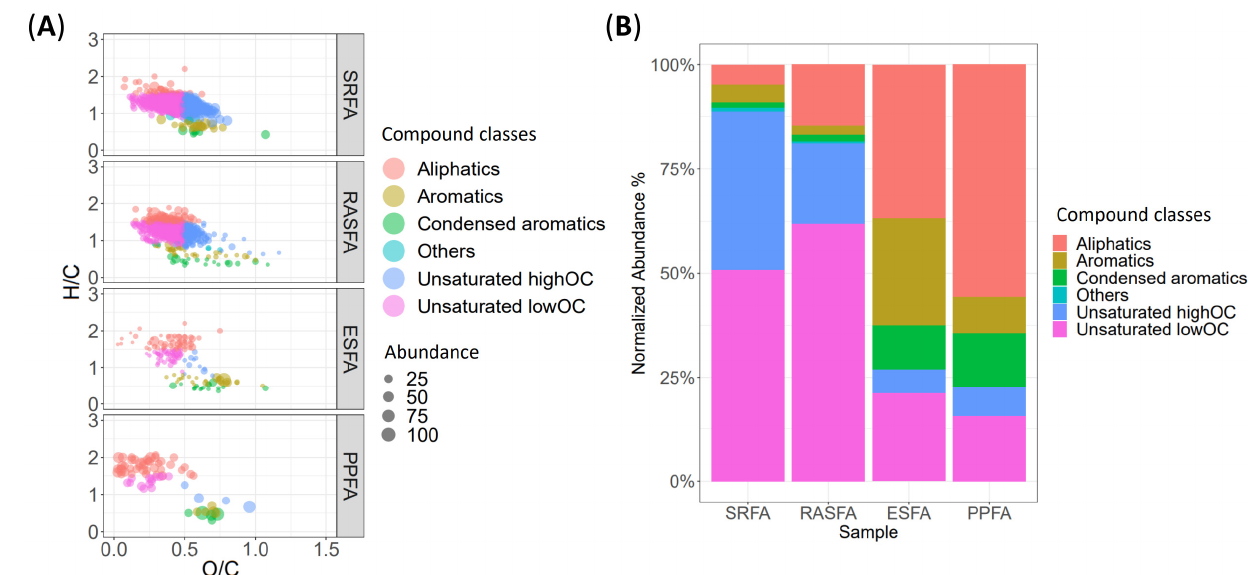
Figure 6. Assigned CHO peaks by ESI-QTOF-MS under negative mode from Suwannee River, Elliott soil, Pahokee Peat and recirculating aquaculture systems fulvic acids (SRFA, ESFA, PPFA and RASFA) classified into five compound classes (aliphatics, aromatics, condensed aromatics, high oxygen “highOC” and low-oxygen “lowOC” unsaturated compounds). The compound classes ranges were based on Hawkes, et al. (2020) [46]. ( A ) Van Krevelen diagrams with H/C and O/C ratios and ( B ) bar chart diagram with the sum-normalized abundances of the compound classes identified in each sample.